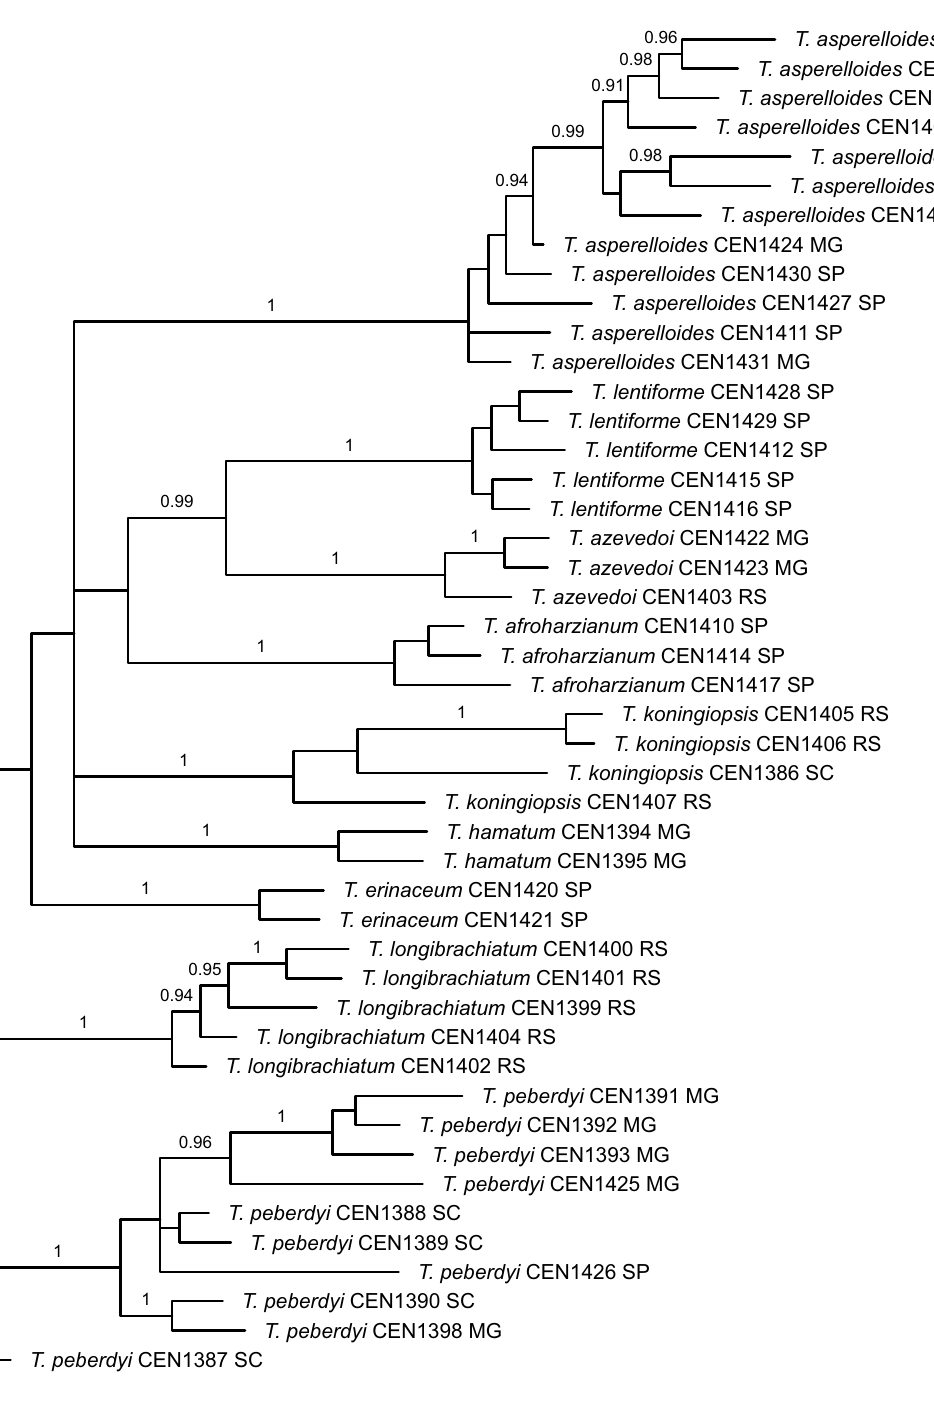
PLOS ONE | https://doi.org/10.1371/journal.pone.0228485 March 4,